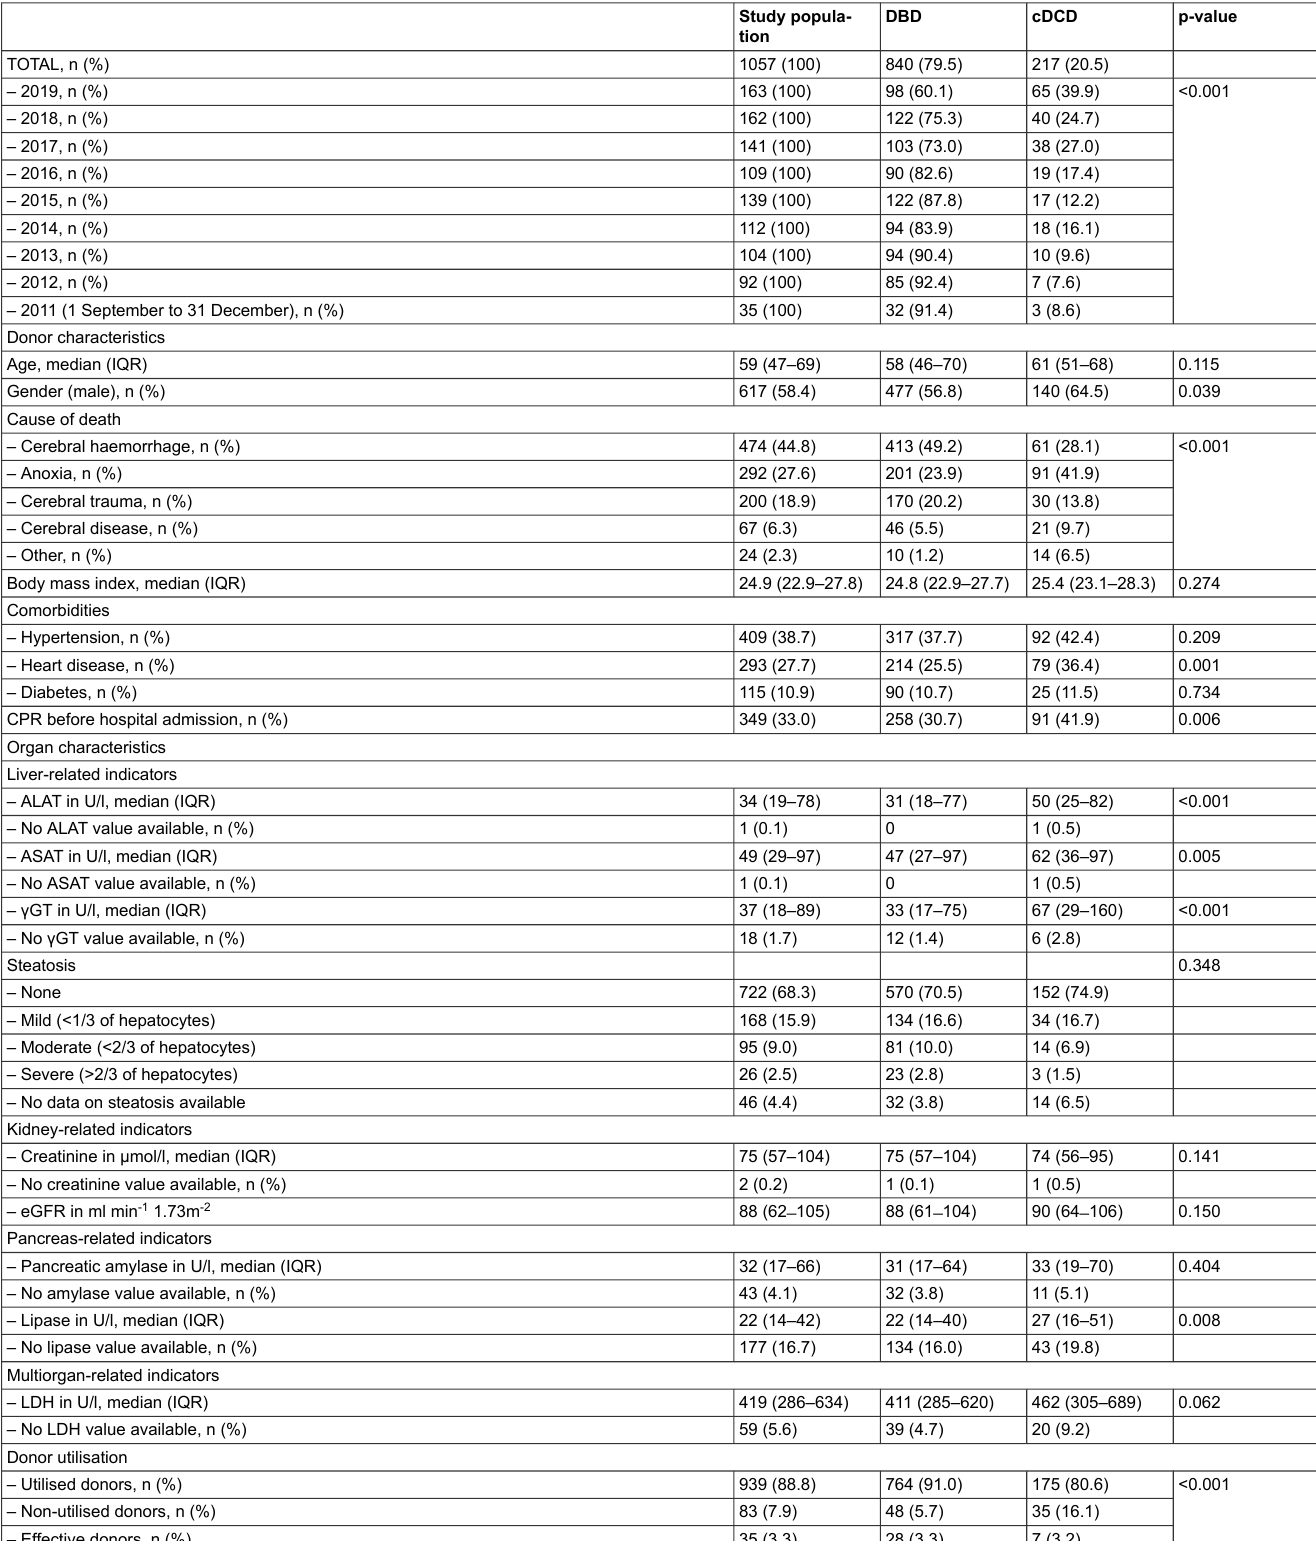
Table 1: Donor and organ characteristics, and donor utilisation of referred and approved DBD vs cDCD donors in Switzerland from 2011–2019. Displayed are medians (IQRs) for numeri- cal variables. For categorical variables, numbers (column percentages) are given, except for total and yearly numbers (row percentages). The variable “year” was treated as nu- merical in the significance test. For cDCD donors the cause of death is equivalent to the cause for withdrawal of life-sustaining therapy